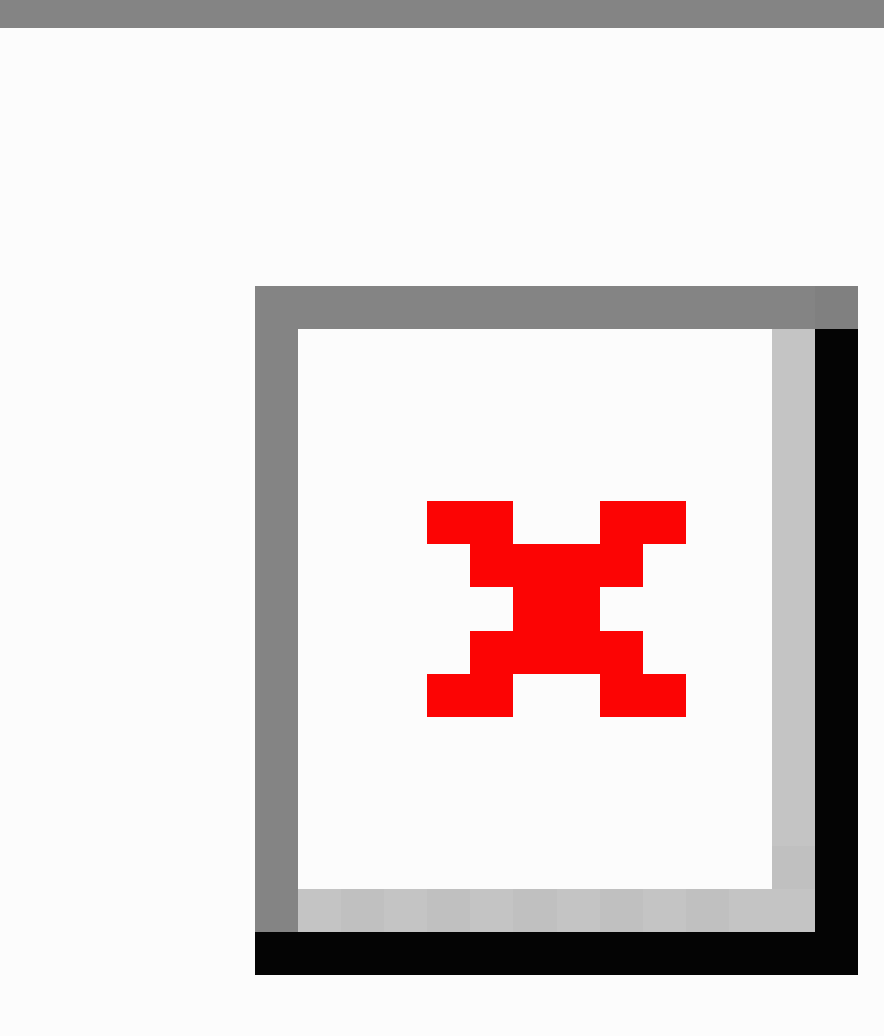
Figure 3. Trainee interface pre- and post-pilot